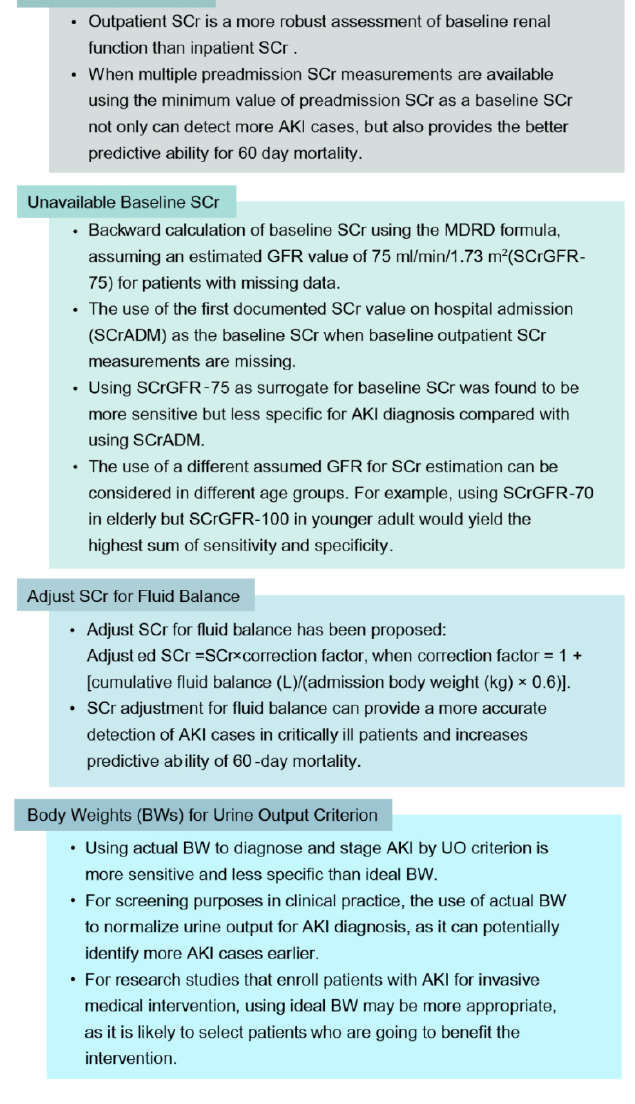
Figure 1. Baseline SCr, Adjust SCr for Fluid Balance, and Body Weights for Urine Output Criterion.